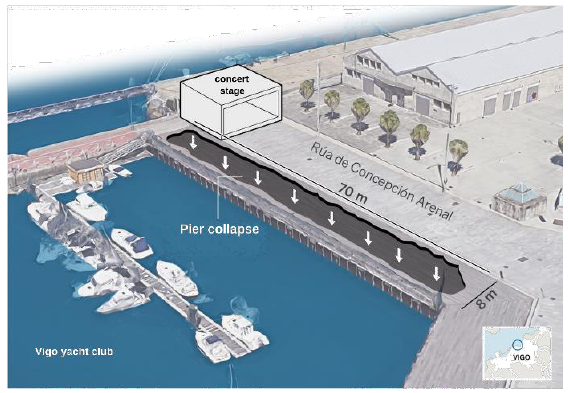
Figure 1 . Situation of the collapsed pier.